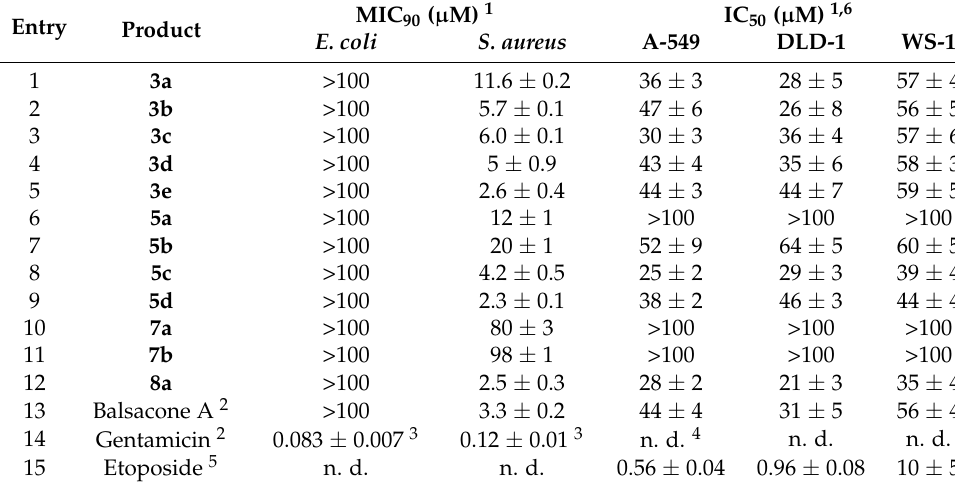
Table 4. Antibacterial and Cytotoxic Activity of Compounds 3a – e , 5a – d , 7a – b , and 8a